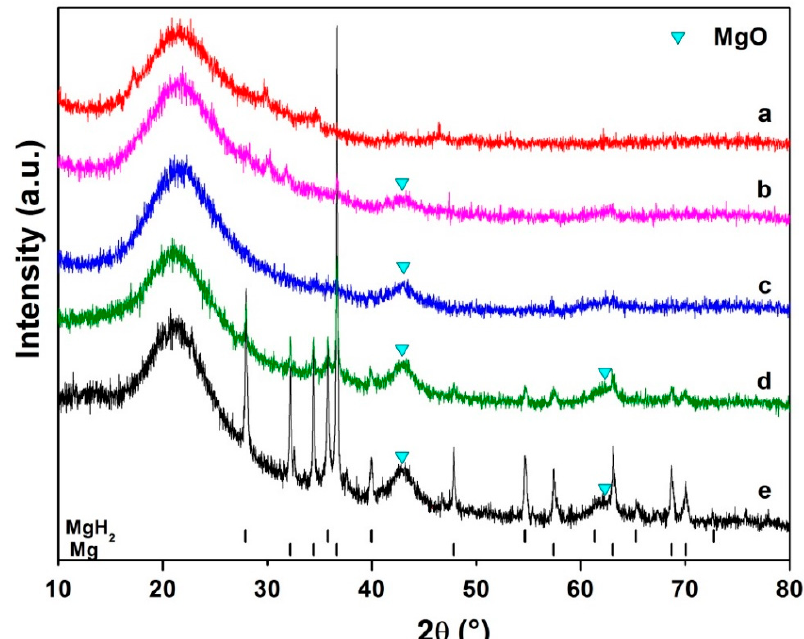
Figure 6. Room temperature PXD pattern of (a) Ca(BH 4 ) 2 , (b) 1Mg(BH 4 ) 2 : 2Ca(BH 4 ) 2 , (c) 1Mg(BH 4 ) 2 : 1Ca(BH 4 ) 2 , (d) 2Mg(BH 4 ) 2 : 1Ca(BH 4 ) 2 , and (e) Mg(BH 4 ) 2 after thermal cycling (DSC analysis up to 440 °C under 2 bar of H 2 ).